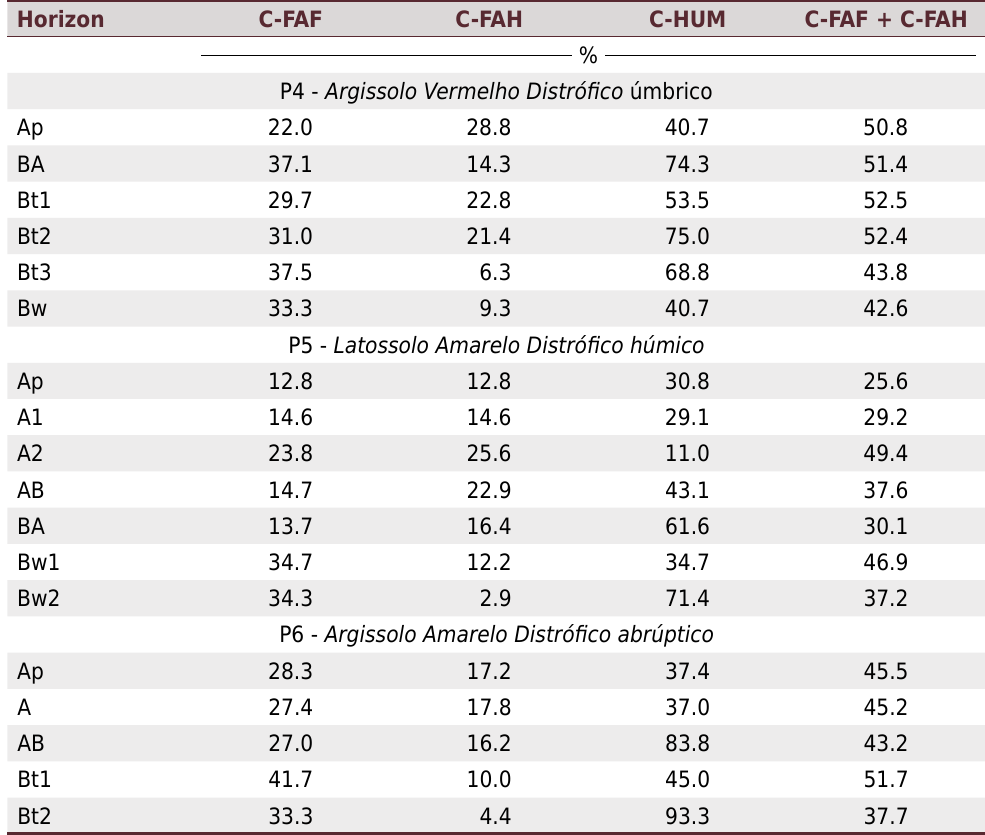
Table 3. Humic fraction contribution to the organic carbon of the soils from the Pito Aceso basin, municipality of Bom Jardim (RJ)